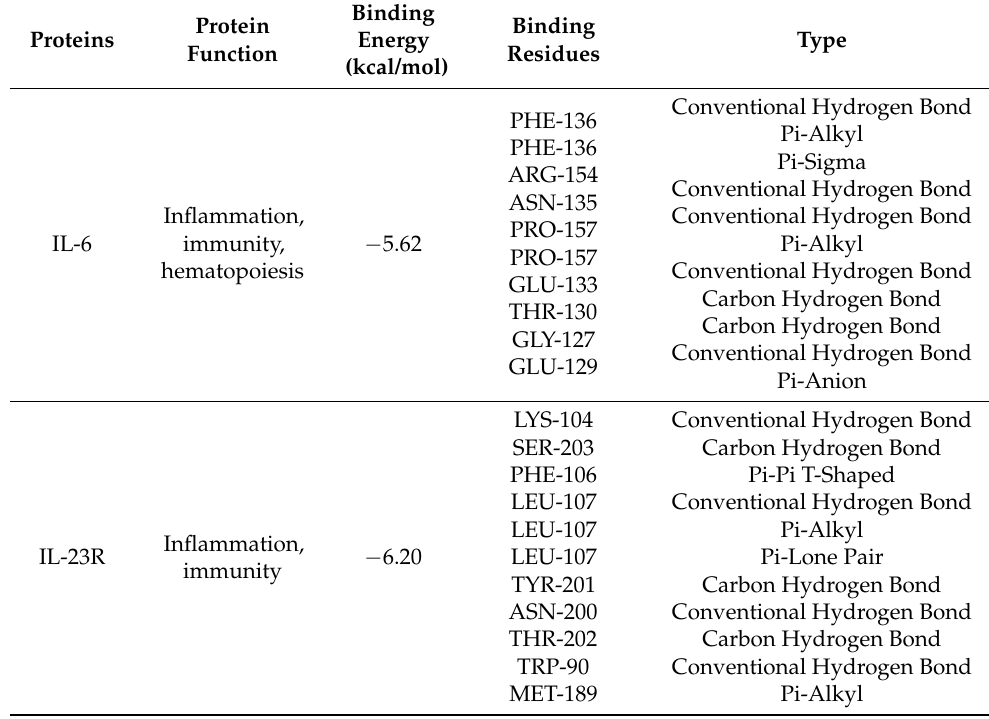
Figure 8. Molecular docking analysis of the putative binding between 11-O-(4’-O-methylgalloyl)-bergenin and IL-6, IL-23R, IL-1 β , IL-10, and SELE. ( A – E ) correspond to the binding models for interactions between 11-O-(4 ′ -O-methylgalloyl)-bergenin and IL-6, IL-23R, IL-1 β , IL-10, and SELE, respectively. Hydrophobic or H-bond interactions are displayed as a colored surface. Table 4. Intermolecular interactions between Fr11 and IL-6, IL-23R, IL-1 β , and IL-10.